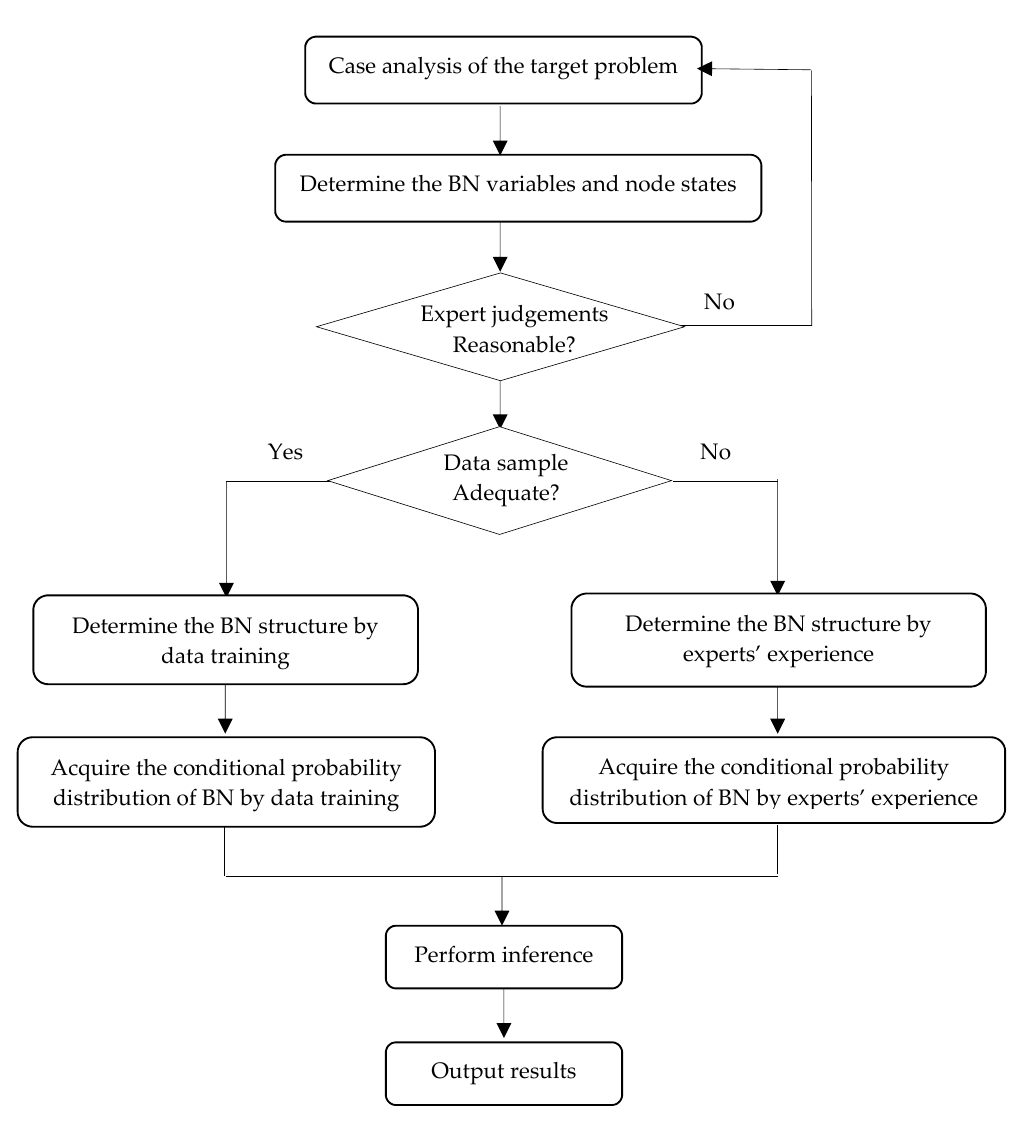
Figure 2. Flowchart of establishing Bayesian network.